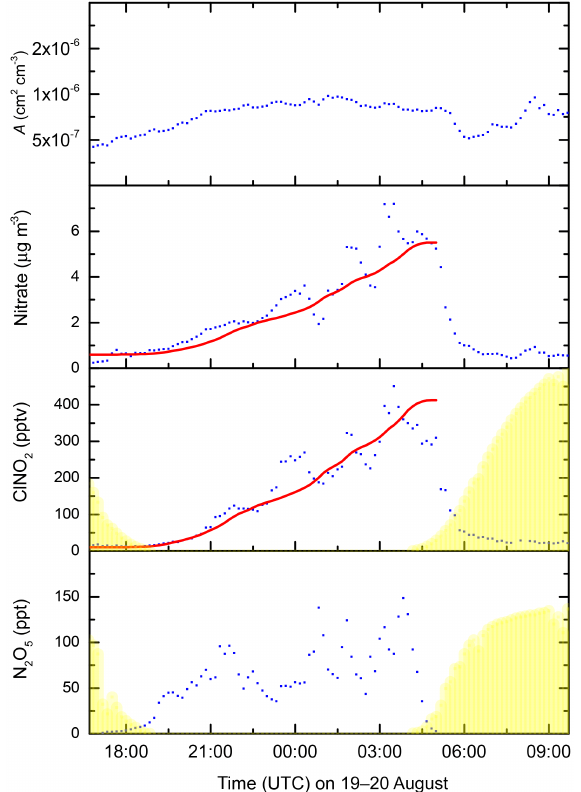
Figure 6. Plot demonstrating the derivation of f and γ from ClNO 2 and NO − measurements using analysis method 1b. The grey area 3 represents the time period in which p ClNO 2 and p NO − sured. Average values of RH, [N 2 O 5 ] and A over the same period are also indicated.